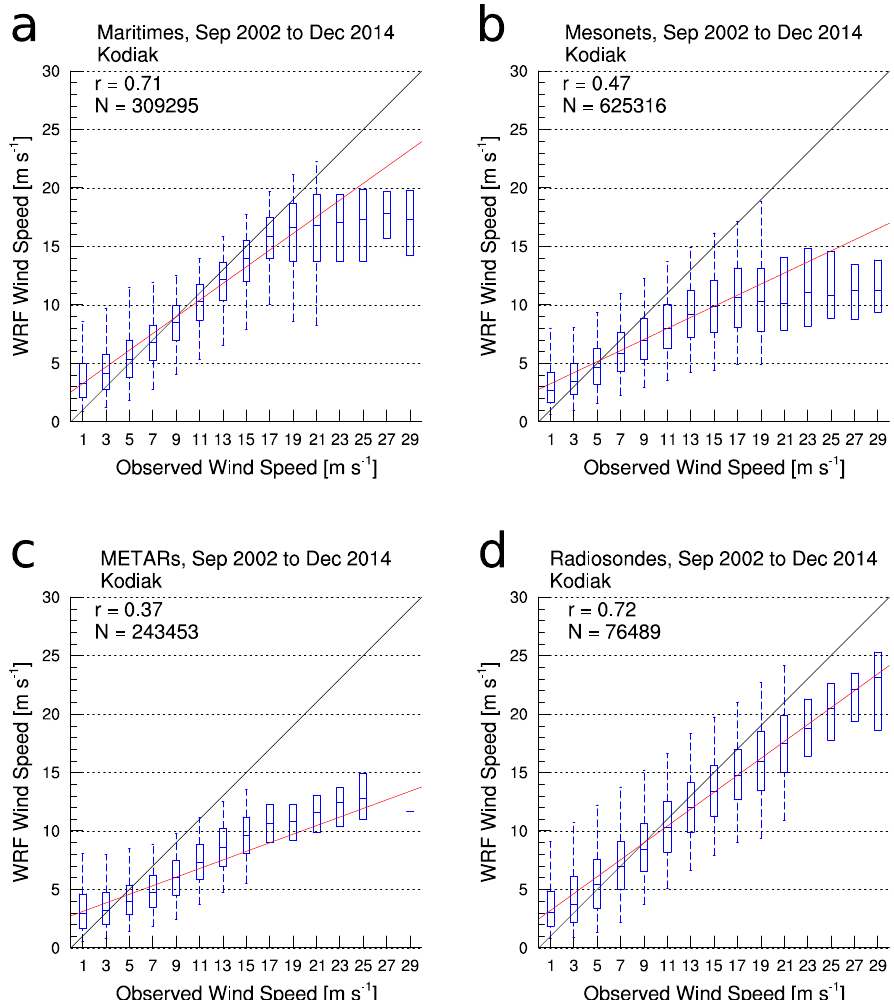
Figure 13. Box plots of model/observation pairs of wind speed in the Kodiak region for the ( a ) maritime, ( b ) mesonet, ( c ) METAR, and ( d ) radiosonde networks, spanning September 2002–December 2014. The thin black line is the 1:1 line, and the thin red line is the regression line. The regression coefficient (r) and sample size (N) are given in the top-left corner of each panel. Each bin width is 2.0 m s − 1 . Each box depicts the median and middle 50% of the bin. Dashed lines extend to the 5th and 95th percentiles when the bin contains at least 1000 points.